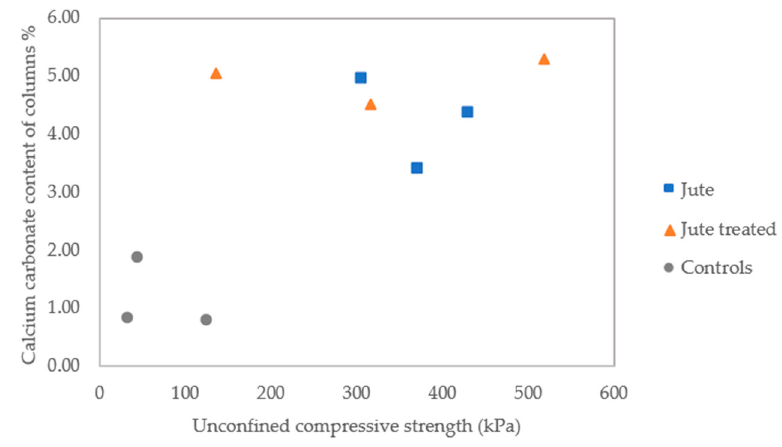
Figure 13. Calcium carbonate content of columns.